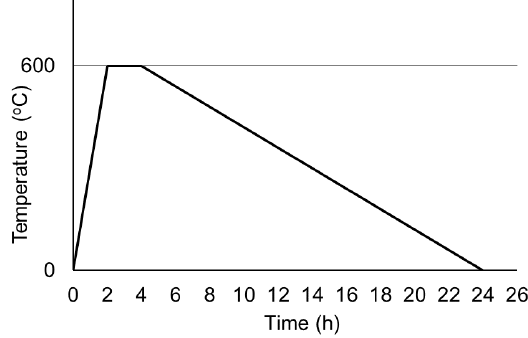
Figure 2. Temperature–time curve.